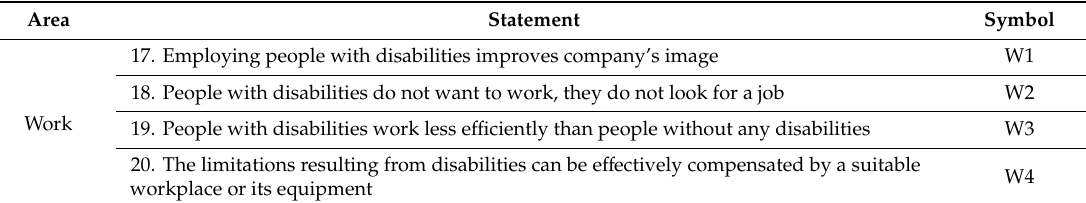
Table 2. Proposed statements on the perception of people with disabilities in the